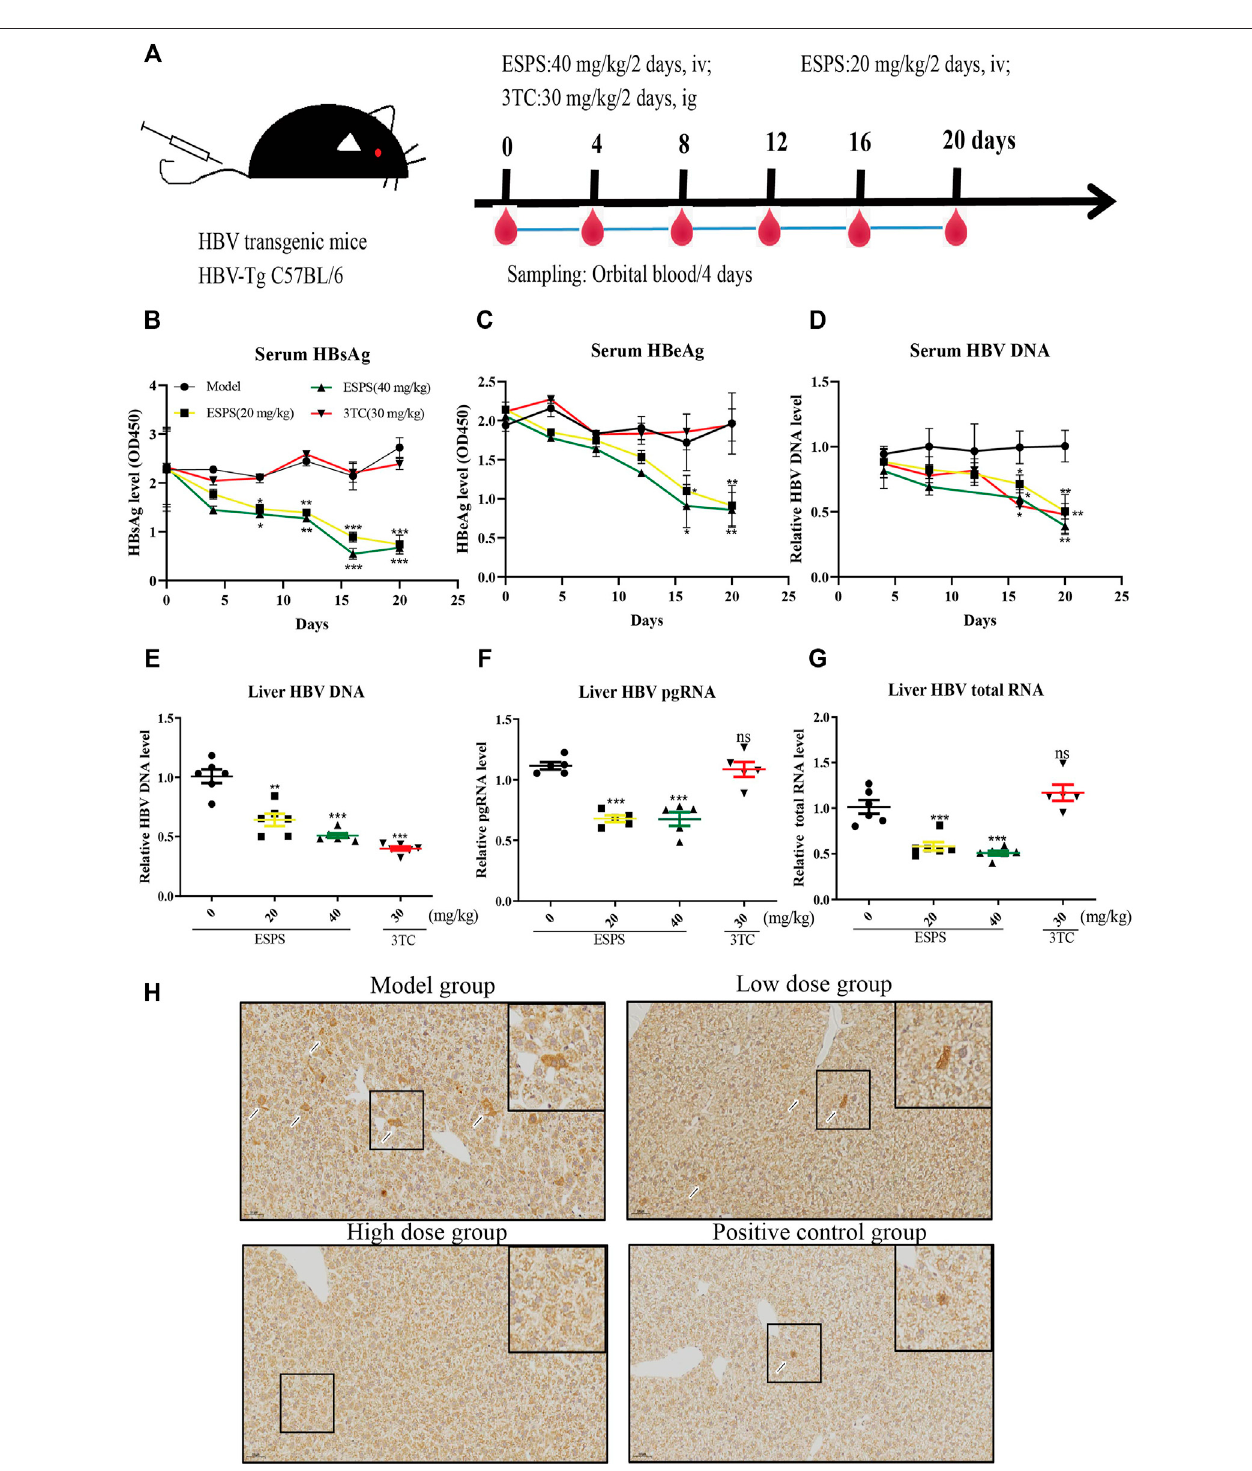
FIGURE 5 | Inhibitory effects of ESPS on HBV in vivo . (A) Experimental process for inhibiting of HBV by ESPS in vivo . C57BL/6J mice were injected with plasmid pAAV-HBV1.2 via HI. On day D-0, the mice were divided into four groups according to the results of HBsAg detection. The blood was taken every 4 days and weighed, and theliver tissue wastakenouton day 20.Aftertreatment withESPSat indicated times,ELISAwasused todetect thelevelsofserum HBsAg (B) and HBeAg (C) .The levelsofcore-associatedDNAintheserum (D) andinthelivertissue (E) ,HBVpgRNA (F) ,andHBVtotalmRNA (G) intheliverissueofmiceweredetectedbyqPCR; HBcAg in the right lobe of model group (PBS treatment group), low-dose group (20 mg/kg/2 days ESPS treatment group), high-dose group (40 mg/kg/2 days ESPS treatmentgroup),andpositivecontrolgroup(30 mg/kg/2 days3TCtreatmentgroup) (H) weredetectedbyimmunohistochemistryonday20.3TCwasused aspositive control. Values are means ± SD ( n = 6). * p < 0.05, ** p < 0.01, *** p < 0.001 vs . the model control group.